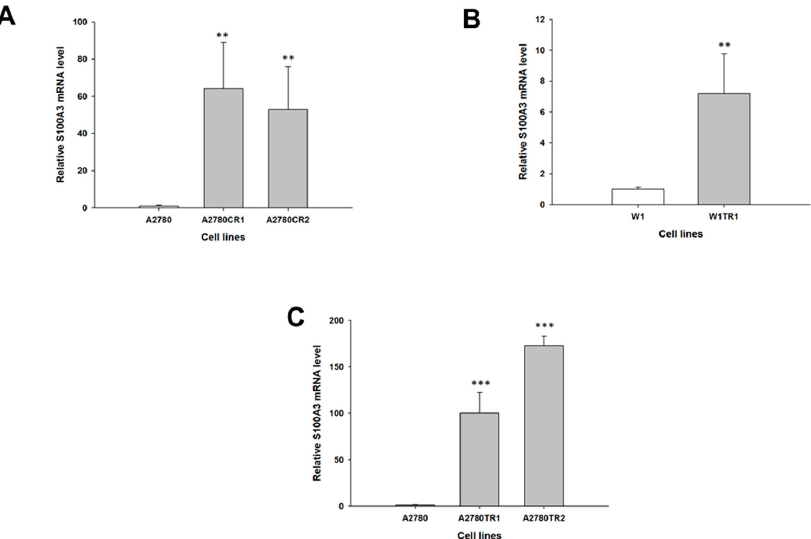
Figure 2. Expression analysis (Q-PCR) of the S100A3 gene in: A2780 CIS-resistant cell lines ( A ); and W1 ( B ); and A2780 ( C ) TOP-resistant cell lines. The figure presents the relative gene expression in resistant cell lines (grey bars) with respect to the sensitive cell line (white bars), assigned as 1. The values were considered significant at ** p < 0.01 and *** p < 0.001.